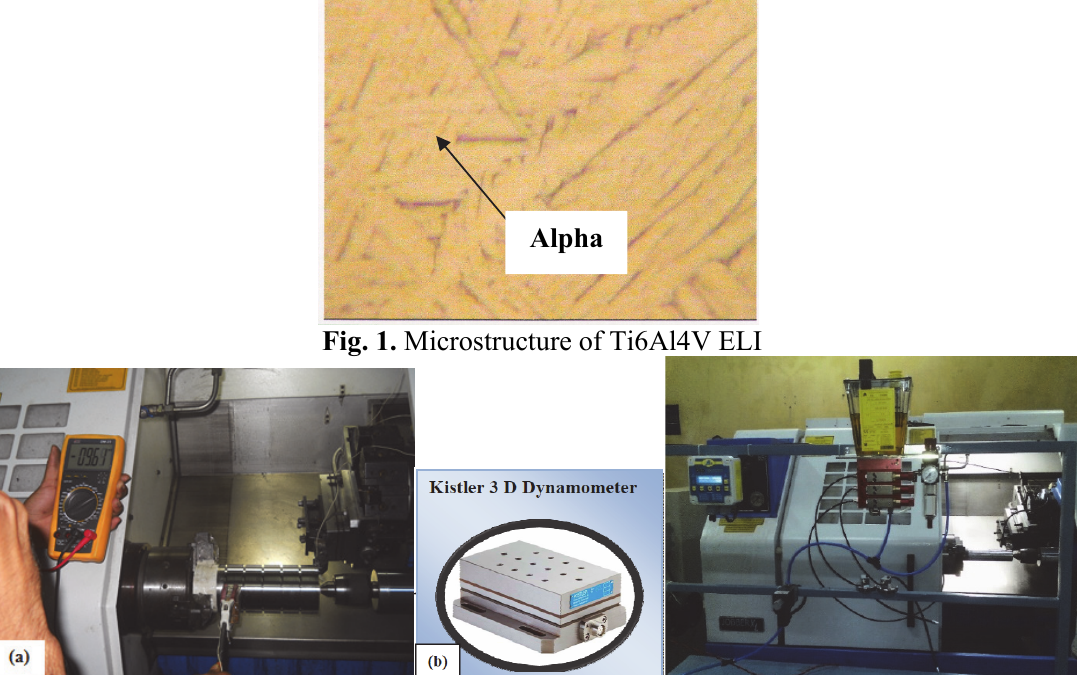
Fig. 2. (a) Photographic view of (a) experimental setup (b) Kistler 3-D Dynamometer unit (c) MQL